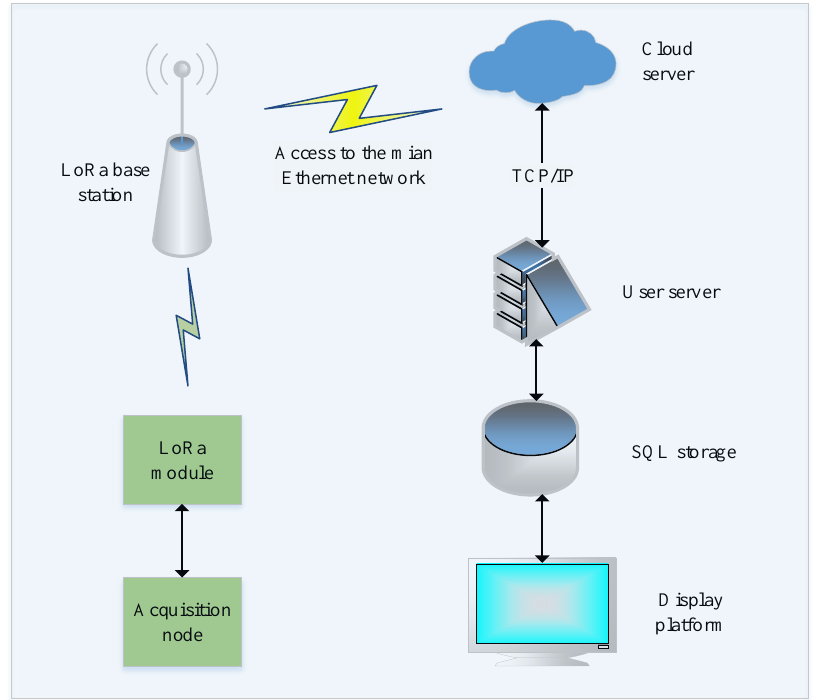
Figure 4. The data communication connection between the user server and the device. TCP/IP = transmission control protocol/internet protocol; SQL = structured query language.